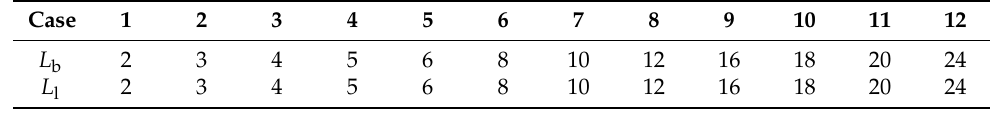
Table 1. Physical dimensions of the strip width of the mixed-wettability surfaces at θ l = 140 ◦ /150 ◦ /160 ◦ and θ b = 180 ◦ (nm).